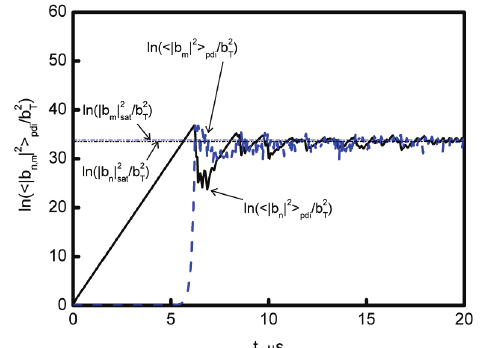
Fig. 2. Temporal evolution of the averaged density of the primary (solid curve) and secondary (dashed curve) UH plasmon energies given in the logarithmic scale. The dash dotted line is ν determined in (31), the dash-dot- 2 t ν with 0,0 0,0 dotted curve is the dependence (35). Two horizontal lines (visually merged) are the saturation levels (36) and